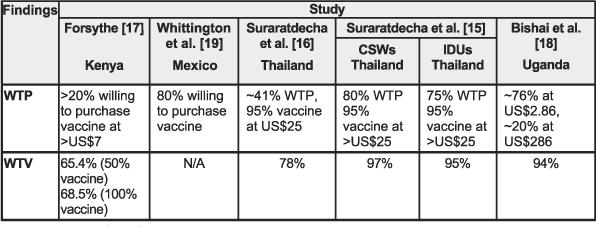
Reported Willingness to Pay and to Be Vaccinated in Four Countries